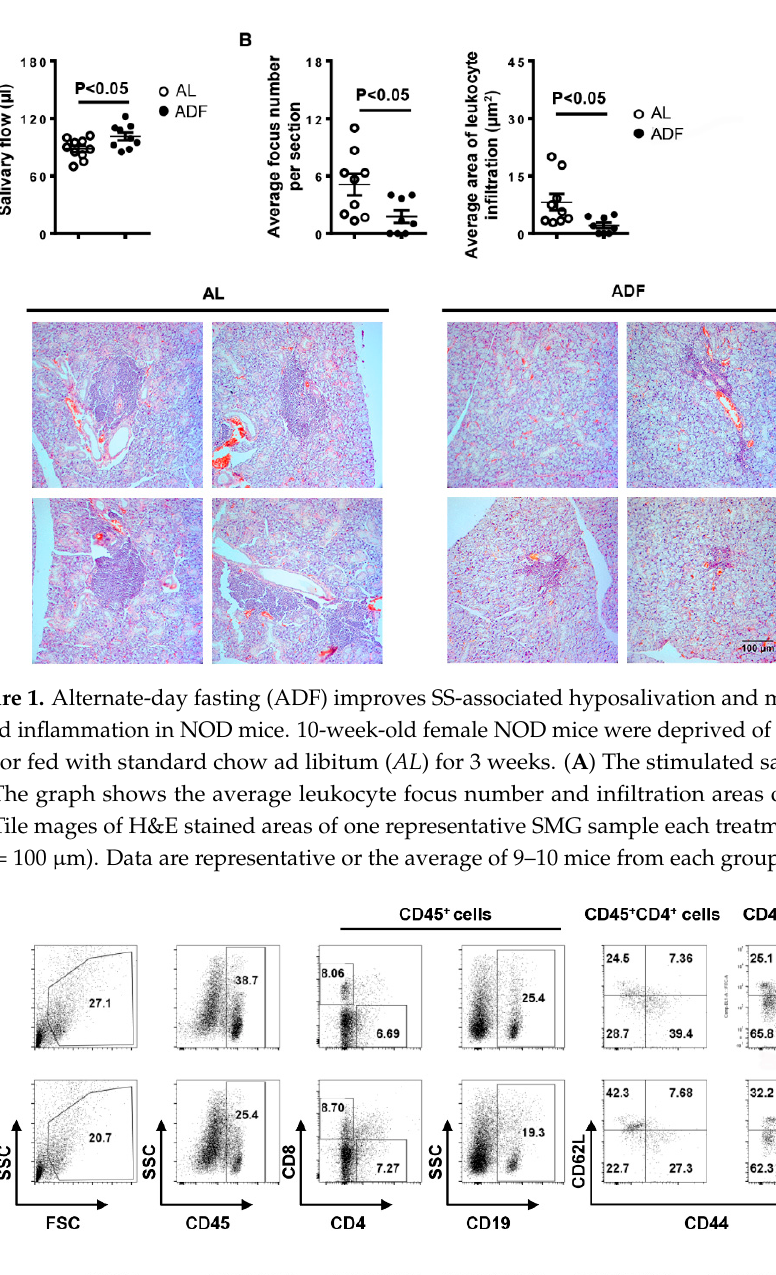
Figure 3. Alternate-day fasting (ADF) down-regulates tissue inflammation-associated genes and up- regulates PPAR pathway target genes, water channel protein AQP5 and tight junction protein clau- din-1 in the SMGs. 10-week-old female NOD mice were deprived of food every other day or fed with standard chow ad libitum ( AL ) for 3 weeks. Real-time qPCR analysis of tissue inflammation- associated genes, chemoattractants, PPAR pathway target genes and salivary gland secretion-re- lated factors, presented relative to that of GAPDH. Data are the average 7–10 mice from each group. 2.3. ADF Decreases the Proportion of Th1 and Th17 Cells without Affecting Total CD4 T-, CD8 T Cells and B Cells in the smLNs We next investigated the effect of ADF on lymphocyte subsets in the smLNs by flow cytometry. NOD mice with ADF exhibited a lower percentage of Th1 cells (CD45 + CD4 + IFN- γ + ) and Th17 cells (CD45 + CD4 + Th17 + ) among total smLN cells than con- trol mice (Figure 4A). In comparison, the frequency of total CD4 T cells, CD8 T cells and B cells in the total smLN cells were not altered by ADF in a statistically significant manner